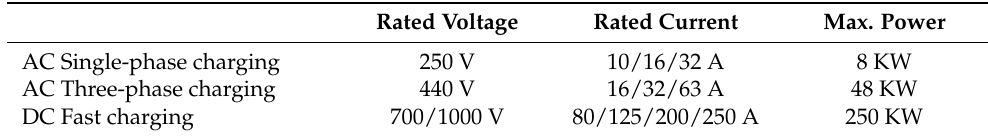
Figure 21. The GB/T AC charging coupler: EV Plug ( Left ) and Inlet ( Right ).